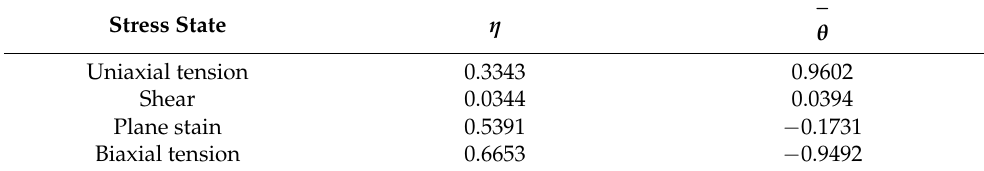
Table 5. Normalized stress triaxiality and Lode angle